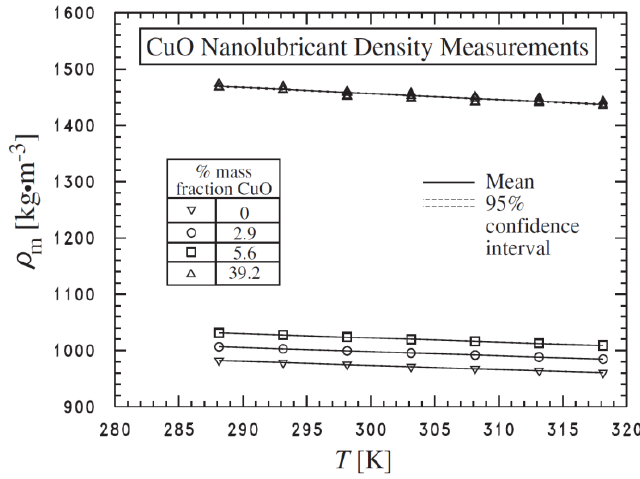
Figure 10. Density of CuO nanolubricant for various mass fractions (measured at atmospheric pressure) [32].